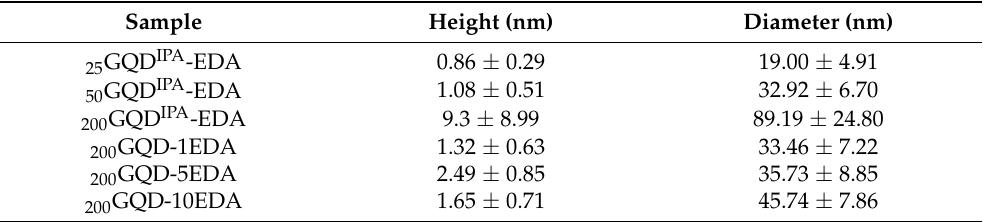
Table 1. The average diameter and the height of GQDs as calculated from AFM images.